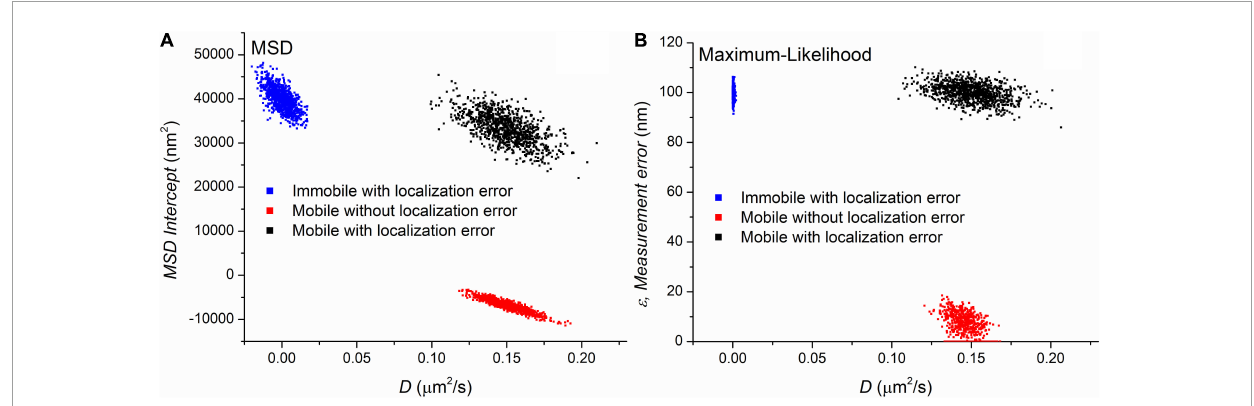
FIGURE1 The parameters extracted by mean square displacement (MSD) (A) and maximum likelihood-based estimation (MLE) (B) based parameter estimation on three set of simulated trajectories. Each point on the graphs represents a set of parameters calculated from a trajectory. The value of diffusion coefficients is shown on the x -axis of both graphs. The y -axis represents another parameters provided by the diffusion coefficient’s estimation, namely they are the y -intercept of the linear fitting and the extracted localization error for the MSD and MLE graph, respectively. The number of trajectories is 1,000 in each